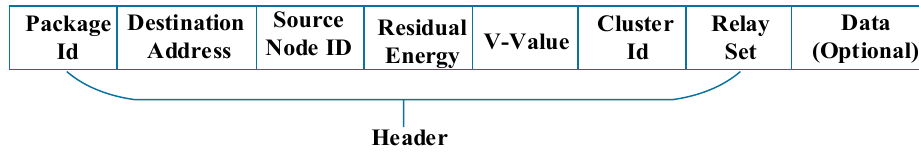
Figure 3. Packet structure of the SROA protocol.